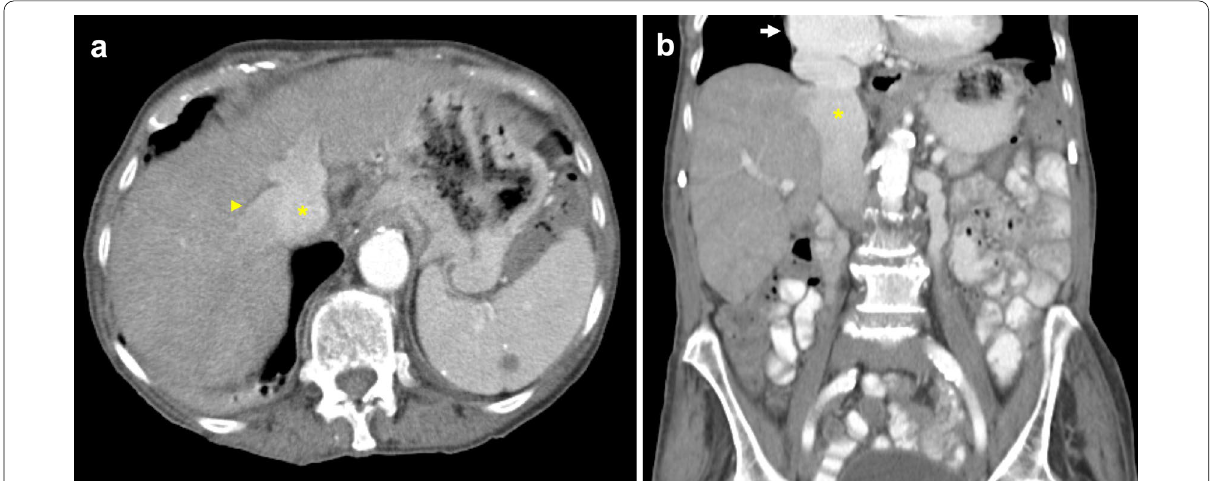
Fig. 25 Dilated IVC from heart failure. a Axial and ( b ) coronal contrast-enhanced CT images demonstrating dilation of the IVC (asterisk) with hepatic reflux of contrast from the right atrium with early opacification (arrowhead) in a patient with clinically evident heart failure. The cardiomegaly (arrow) is partially